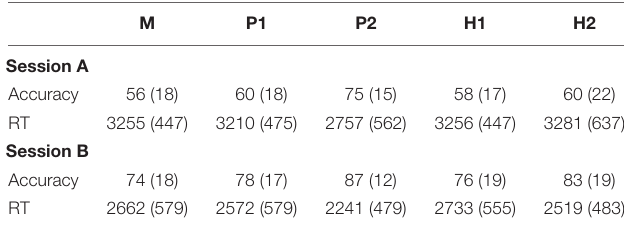
TABLE 3 | The accuracy data (%) and RT data (ms) of 4-to-1 forced choice task: mean (SD). M P1 P2 H1